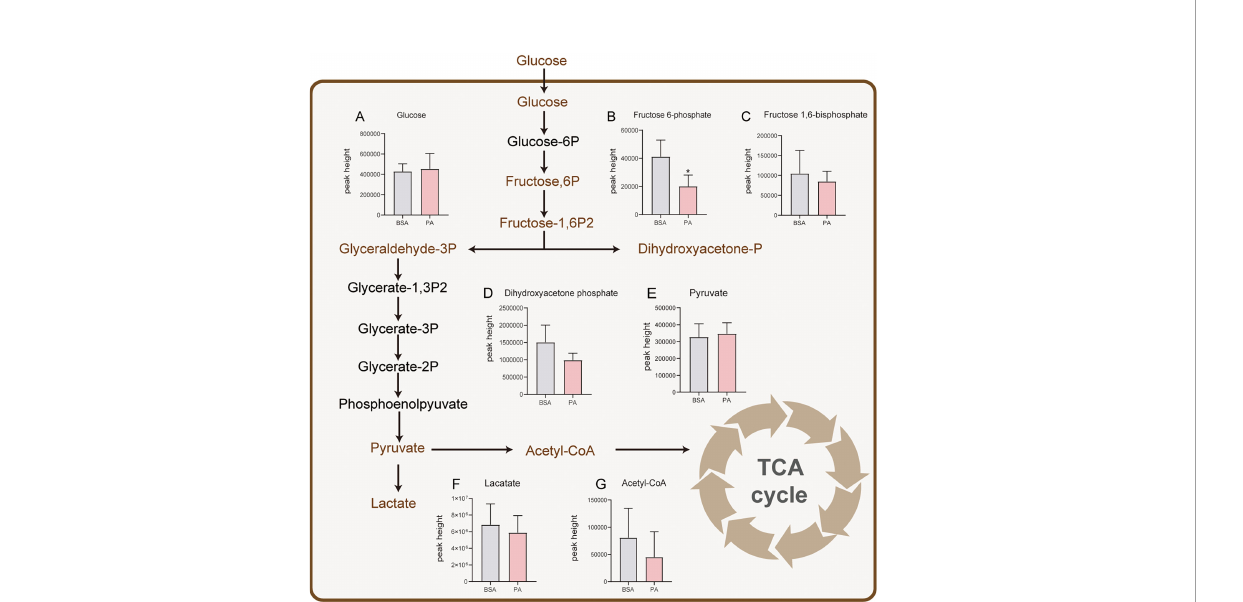
FIGURE 2 Effect of PA on glucose and lactate metabolism of SCs. After glucose is taken up by SCs, pyruvate is produced through glycolysis. Most of the pyruvate is used to produce and secrete lactate for GCs to provide energy, and only a small part of pyruvate participates in the TCA cycle. Levels of glucose (A) , fructose-6-phosphate (B) , fructose-1,6-bisphosphate (C) , dihydroxyacetone phosphate (D) , pyruvate (E) , lactate (F) , and acetyl-CoA (G) . The metabolites marked in brown were detected by metabolomics analysis. The red columns represent the PA group, and the grey columns represent the BSA group. Data were expressed as mean ± SD, *p <